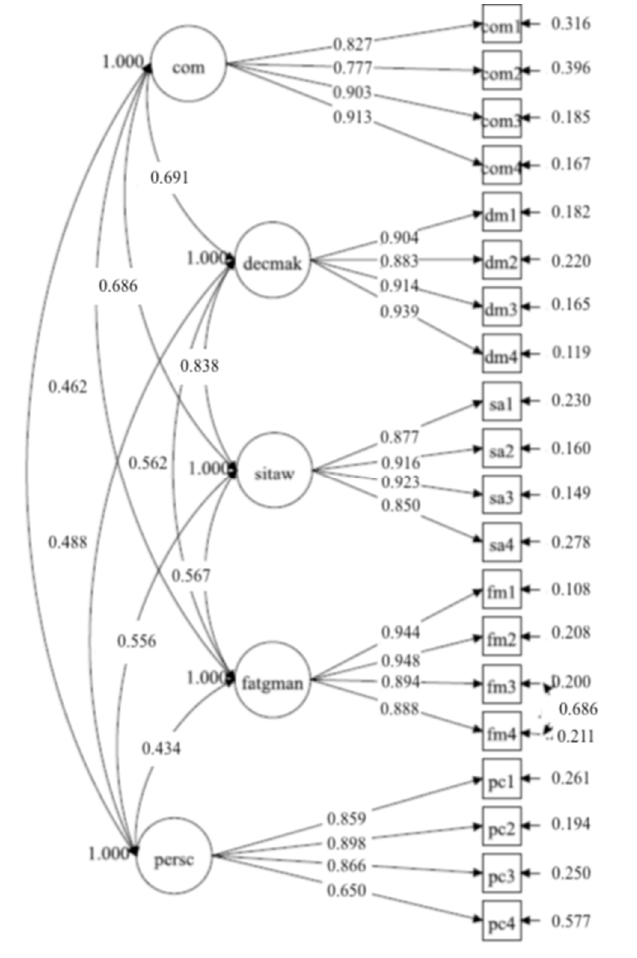
Figure 1. SAPH@W: CFA model on Sample-A ( n = 542).